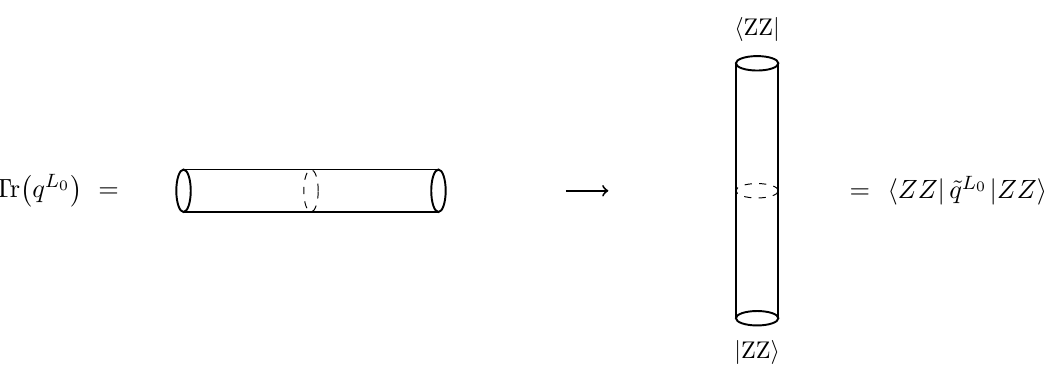
Figure 3 . The identity character can be represented as the annulus partition sum of the Virasoro CFT, or by using channel duality, as the transition amplitude between two ZZ boundary